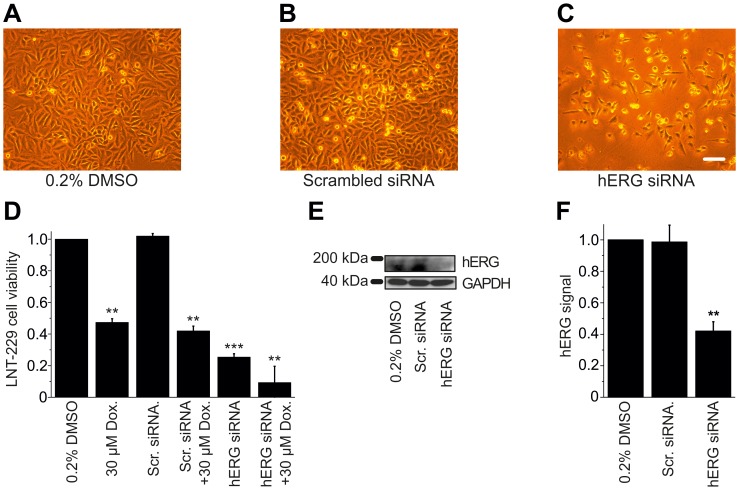
Knock down of hERG channel protein mimics pro-apoptotic effects of doxazosin.(A–C) Representative microphotographs reflect viability of LNT-229 cells treated with small interfering RNA (siRNA) to suppress hERG expression (C) compared to controls exposed to DMSO (solvent; A) or scrambled siRNA (B). Scale bar, 100 µm. (D) XTT assay-based quantification of apoptotic cells following indicated treatment normalized to solvent controls (n = 4 to 6 assays;). Reduced viability associated with doxazosin or hERG siRNA treatment was further increased by simultaneous application of both compounds. (E, F) Western blot analysis (E) and corresponding mean hERG expression levels normalized to GAPDH expression (F) confirmed hERG protein knock down by ∼58%. Data are given as mean ± SEM (**p<0.01; ***p<0.001). Scr, srambled siRNA; GAPDH, glyceraldehyde-3-phosphate dehydrogenase.